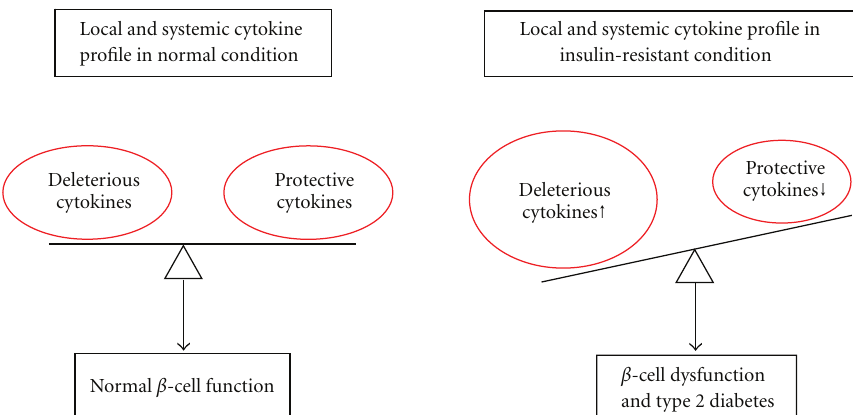
Figure 1: Cytokines play important roles in regulation of pancreatic β -cell function. The disturbed balance of deleterious and protective cytokines in islets and plasma plays crucial roles in the development and progression of β -cell dysfunction and type 2